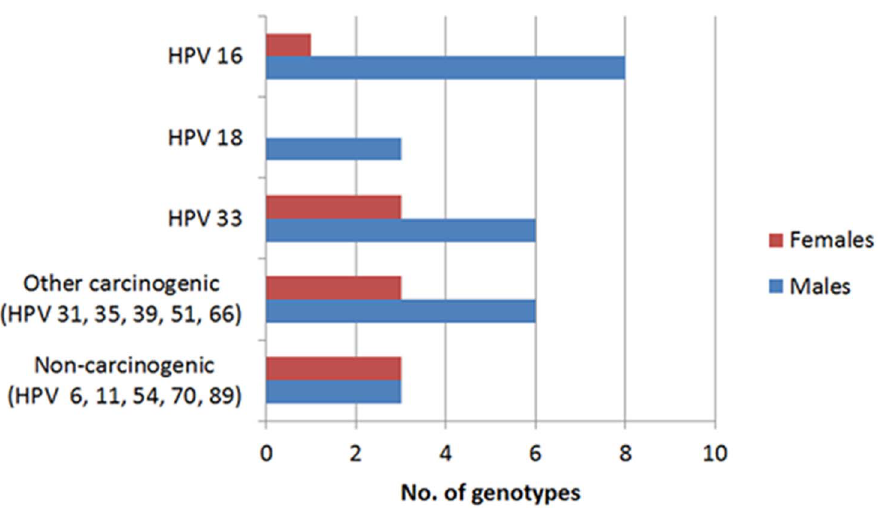
Fig. 1. Distribution of HPV genotypes in HPV positive tumors (male n 5 22; female n 5 9).